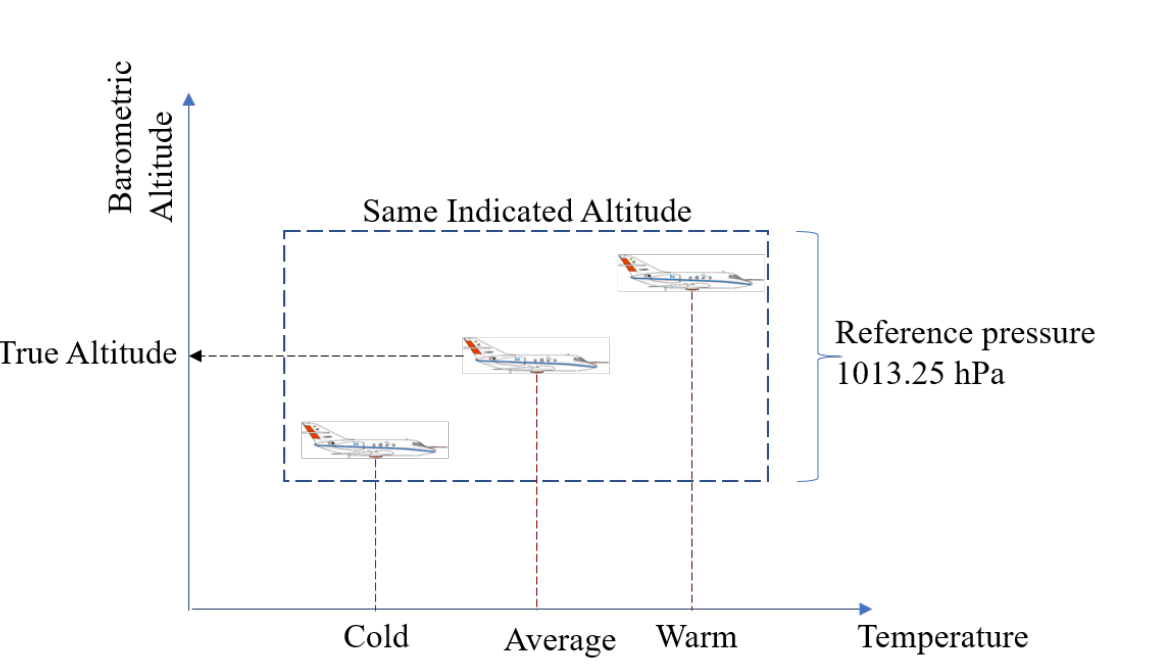
Figure 1. The indicated altitude significantly deviates from the true altitude of the aircraft based on the variation of the temperature from the ISA reference values in warmer or colder